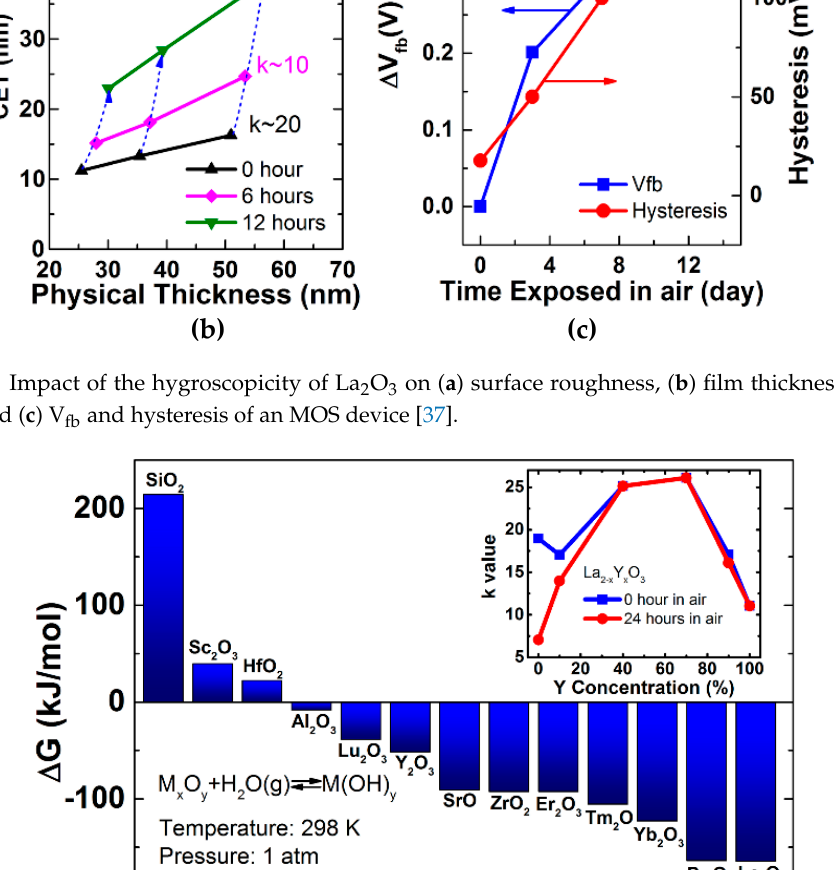
Coatings 2019 , 9 , x FOR PEER REVIEW Figure 5. Impact of the hygroscopicity of La 2 O 3 on ( a ) surface roughness, ( b ) film thickness and k value, and ( c ) V fb and hysteresis of an MOS device [37].